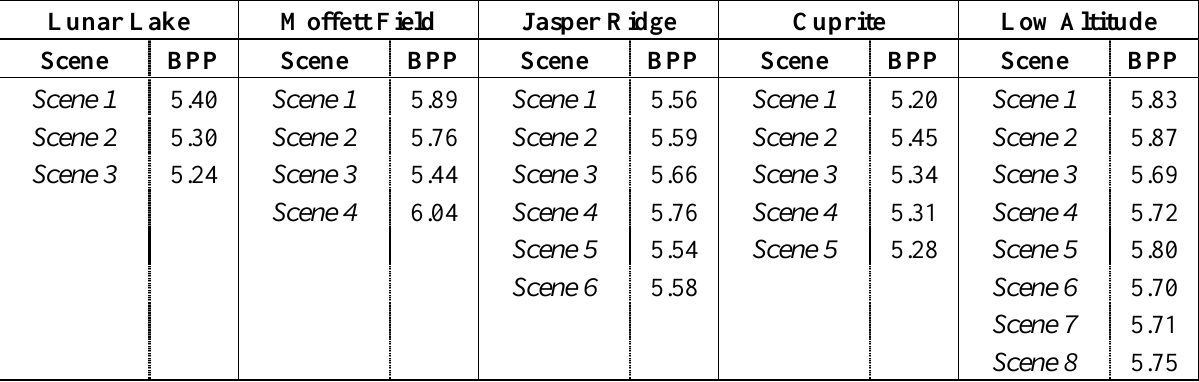
Table 6. Results (BPP achieved for each scene of the hyperspectral imagery with Bhattacharyya distance-based band